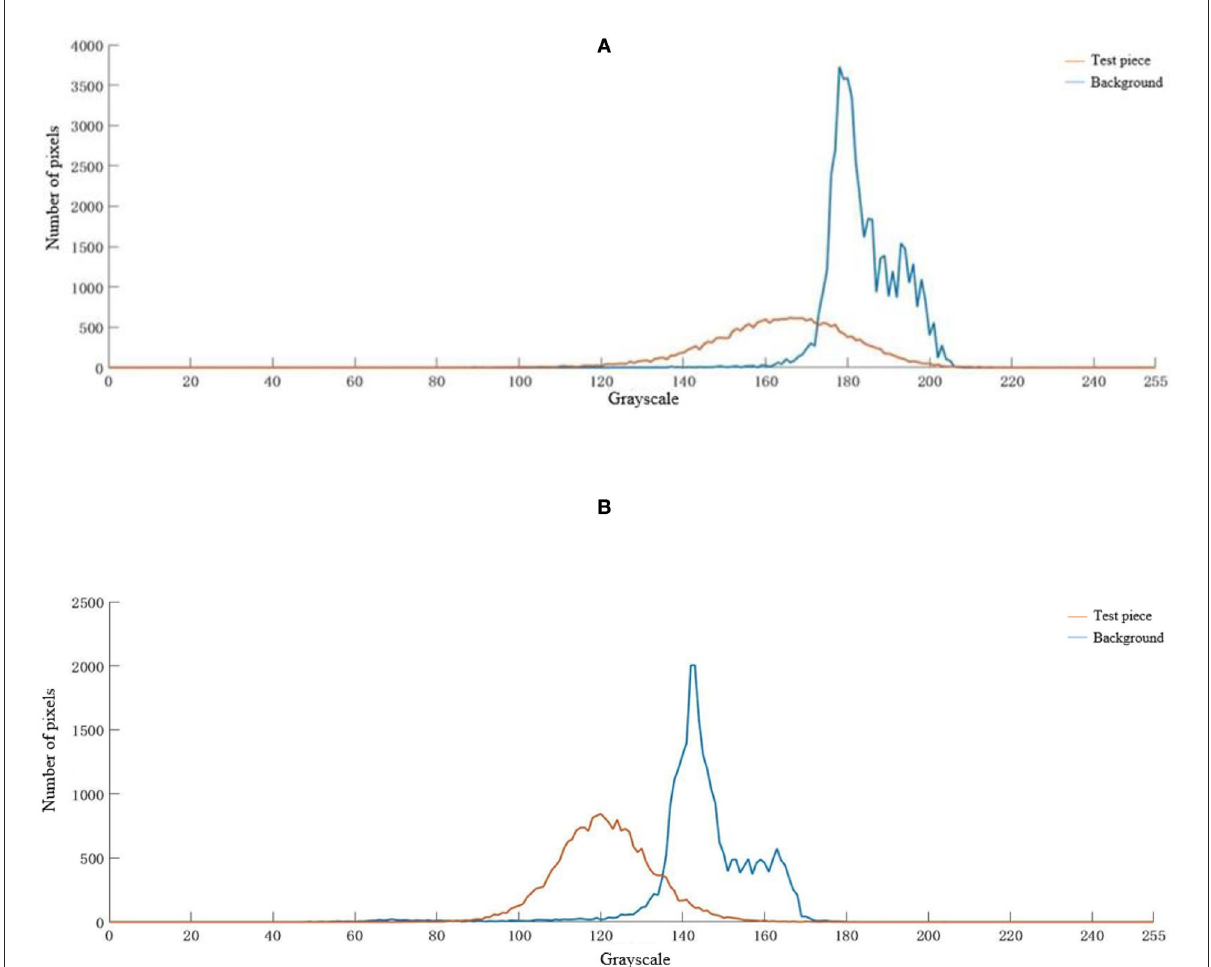
FIGURE18 Color histogram of test piece and background under different meteorological conditions. (A) Sunny, (B)